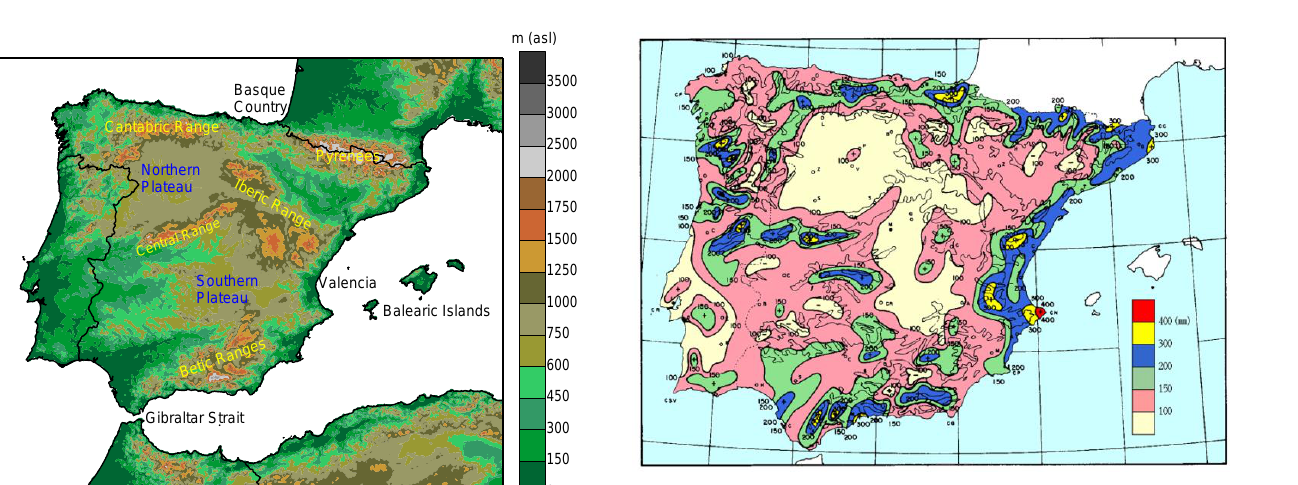
Fig. 1. Orography of the Iberian Peninsula. Locations referred to in Figure 1.- Orography of the Iberian Peninsula. Locations referred to in the text are indicated. the text are indicated.